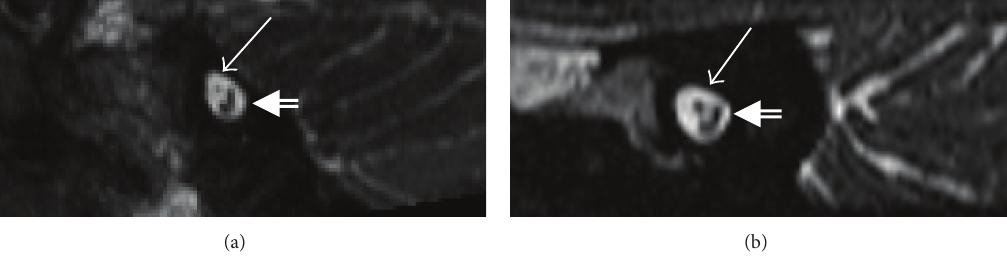
Figure 14: Moebius syndrome. Sagittal oblique CISS sequence of the internal auditory canal in a patient with Moebius syndrome (a) demonstratesthesmallcaliberofthehypoplasticfacialnerveintheanteriorsuperioraspectofthecanal(arrow).Thenormalvestibulocochlear nerve is seen posteriorly (double lined arrow). Sagittal oblique CISS image in a normal patient (b) demonstrates the normal caliber of the facial (solid arrow) and vestibulocochlear (double lined arrow) nerves for comparison.